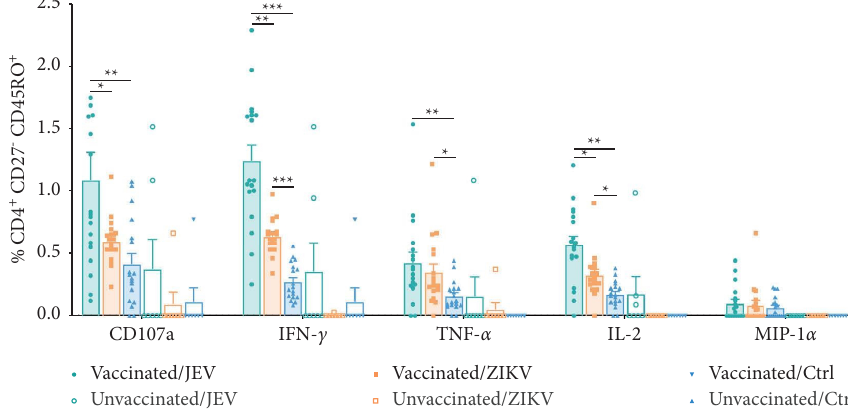
Figure 4: Multifunctional characterization of CD4 + CD27 − CD45RO + efector memory Tcell (T subpopulations were gated on cells expressing at least one of the fve Tcell functions analyzed, and the frequency of cells expressing any of the fve cell functions was assessed. Vaccinated, n � 18; unvaccinated, n � 7. Results are expressed as mean ± SD. Diferences between unmatched groups were compared using an unpaired t -test, the Mann–Whitney U test, or the Kruskal–Wallis rank-sum test with Dunn’s post hoc test for multiple comparisons. ∗ P < 0 . 05, ∗∗ P < 0 . 01, and ∗∗∗ P < 0 .